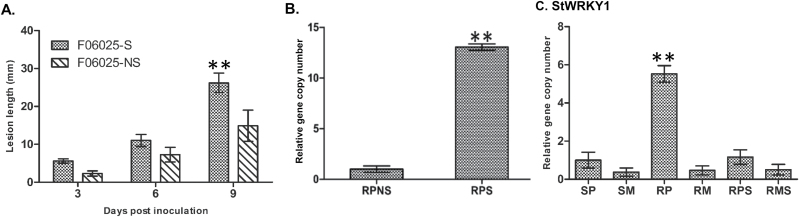
Effect of StWRKY1 silencing on late blight resistance mechanisms. (A) Late blight disease severity progress. Disease severity was quantified as lesion length (mm) at 3 d intervals. (B) Biomass of P. infestans on silenced (S) and non-silenced (NS) resistant potato genotypes. Biomass was quantified as relative P. infestans-specific (O-8) gene expression at 6 dpi. Relative transcript expression of (C) StWRKY1, and phenylpropanoid genes for (D) 4-coumarate:CoA ligase, (E) tyramine hydroxycinnamoyl transferase, (F) tyrosine decarboxylase, and (G) hydroxycinnamoyl transferase. Relative transcript expression was measured at 48 hpi in comparison with reference genes for elongation factor-1α and β-tubulin. RPS indicates resistant silenced and inoculated with P. infestans; RMS indicates resistant silenced and inoculated with mock-solution; see main text for further details. Significant differences in expression levels in RP compared with SP using Student’s t-test: *P<0.05, **P<0.01.